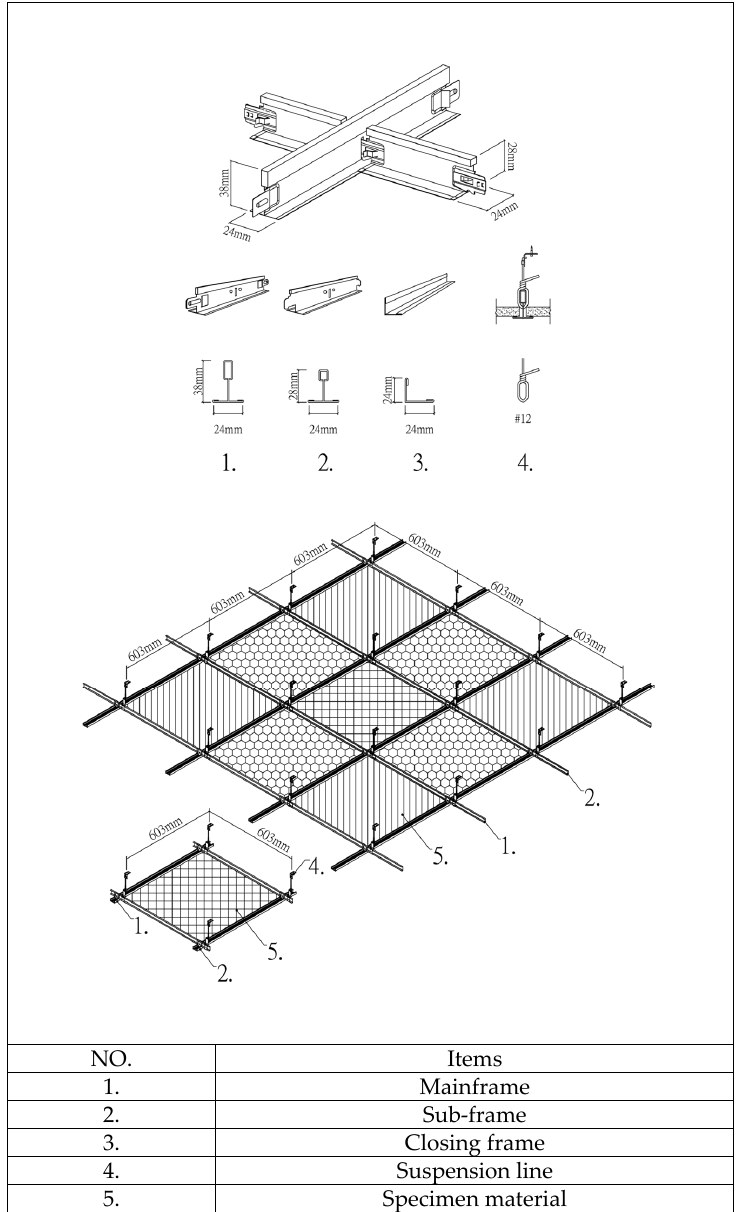
Figure 6. Suspension ceiling system.